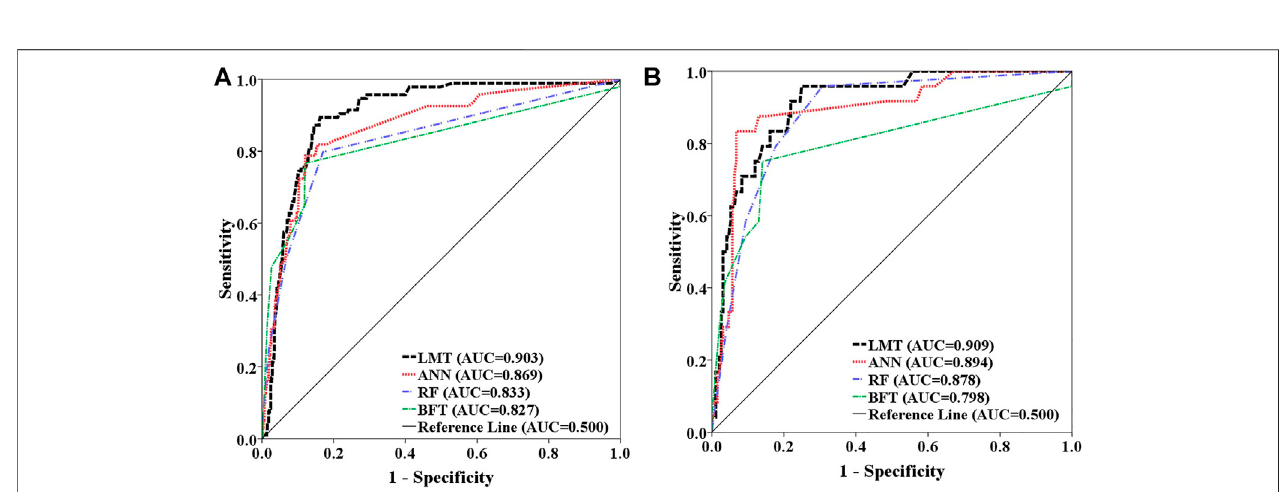
FIGURE 7 | Areas under the curve (AUC) for (A) training dataset, (B) validation dataset.